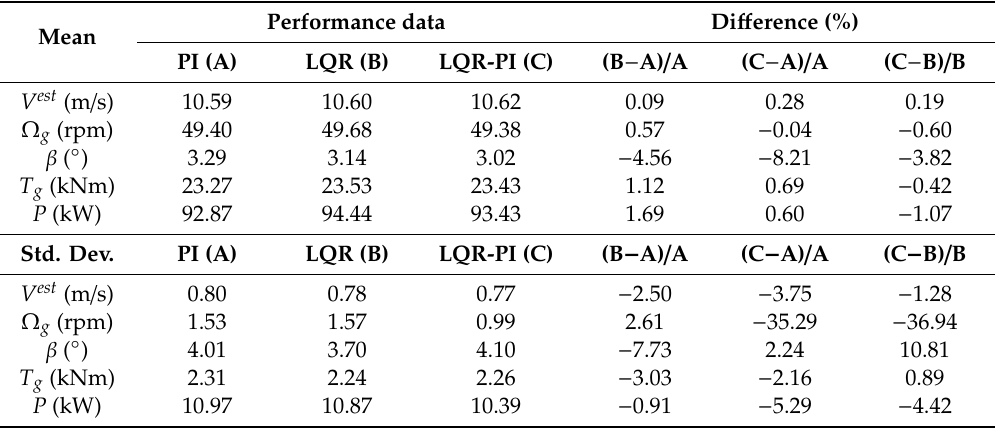
Table 4. Quantitative comparison of the performance data in the transition region in the presence of noise.